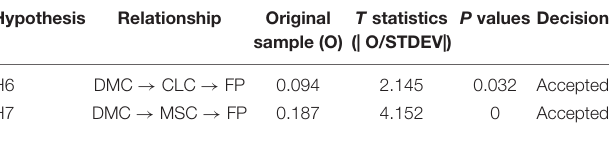
TABLE 4 | Indirect relationship.